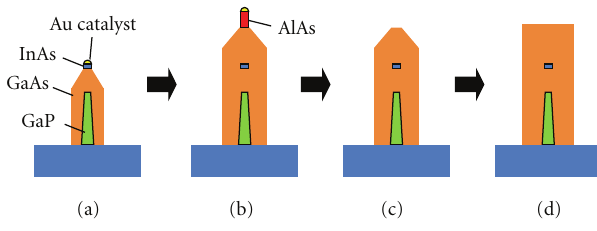
Figure 2: Cross-sectional schematic images of nanopillars explain- ing the fabrication process. (a) InAs/GaAs/GaP nanowires on Si(111); (b) GaAs and AlAs growth; (c) after removal of AlAs together with Au particles; (d) GaAs